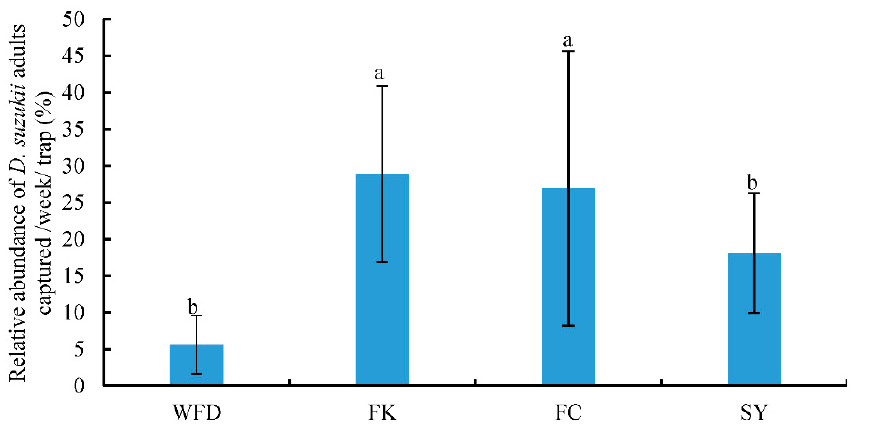
Figure 2. Relative abundance (mean ± SE) of D. suzukii adults captured from different locations. Different letters above the bars indicate a significant difference between locations ( p < 0.05, LSD).